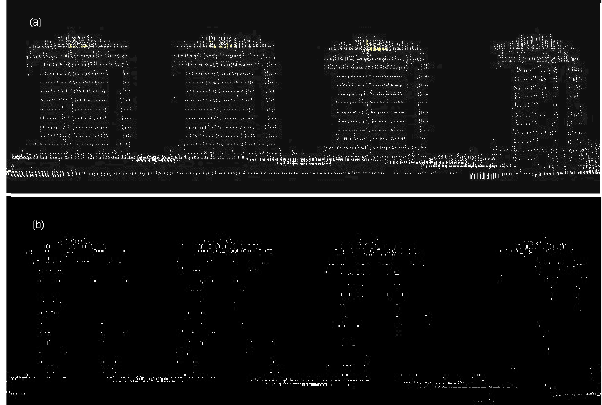
Figure 7. Vertical view of the buildings. (a) Before the building façade weakening (b) After weakening the building façade